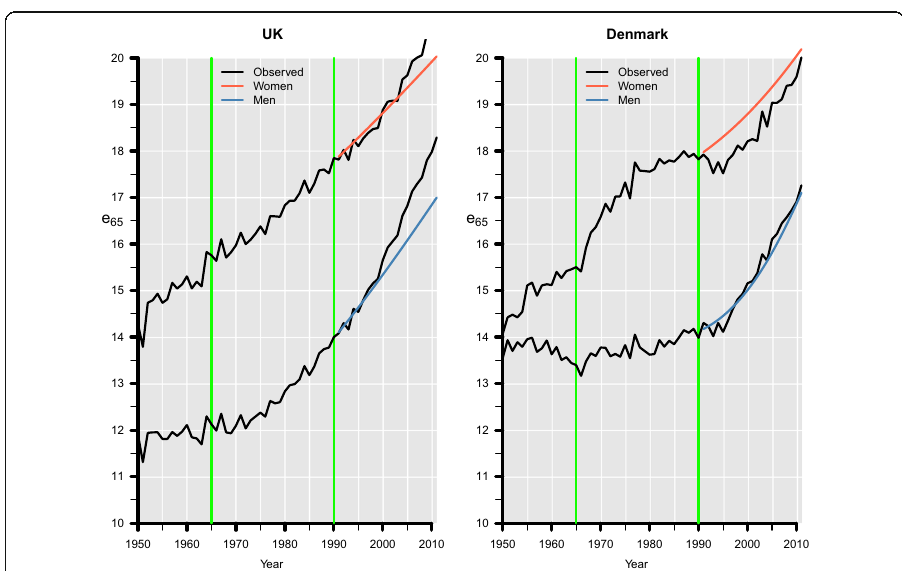
Fig. 11 Validating forecasts of remaining life expectancy at age 65 for British ( left ) and Danish ( right ) women ( red ) and men ( blue ) of the proposed model. Observed data are depicted in